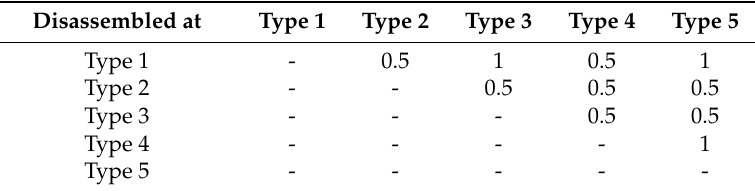
Table 1. Example of the different levels of machine solicitation related to the type of disassembly for the proposed system.